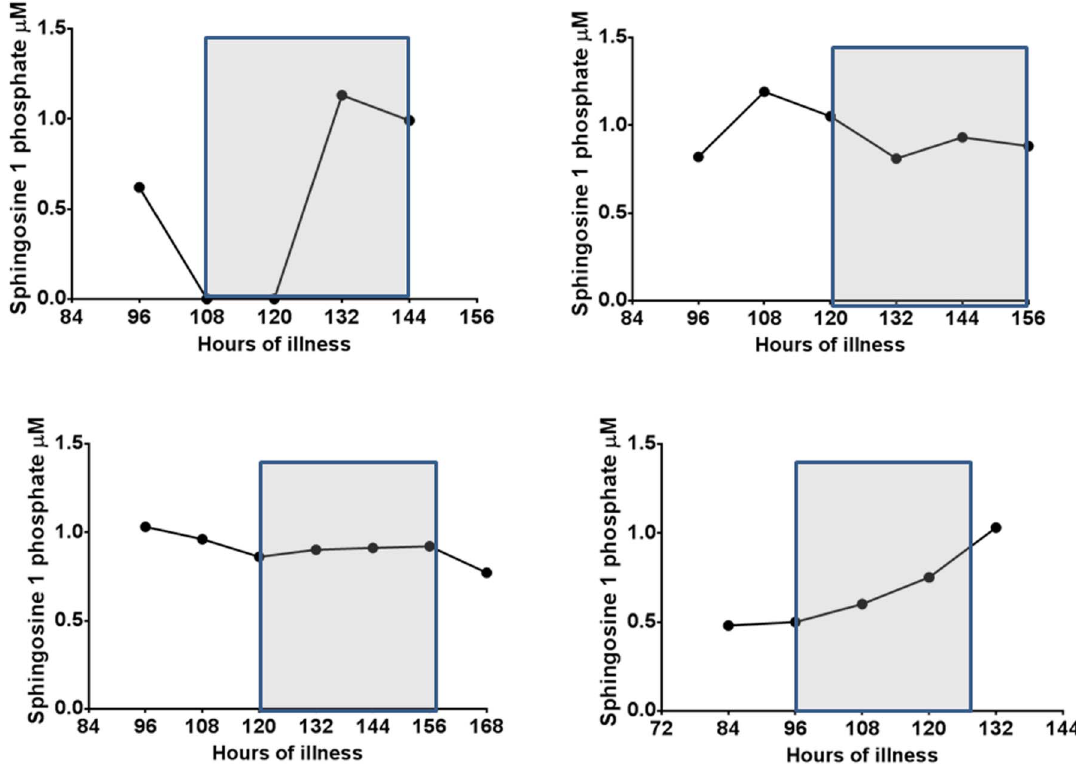
Figure 3. Variation of serum S1P levels in patients with DHF: Kinetics of S1P levels in 4 patients with DHF. The critical phase is shaded.